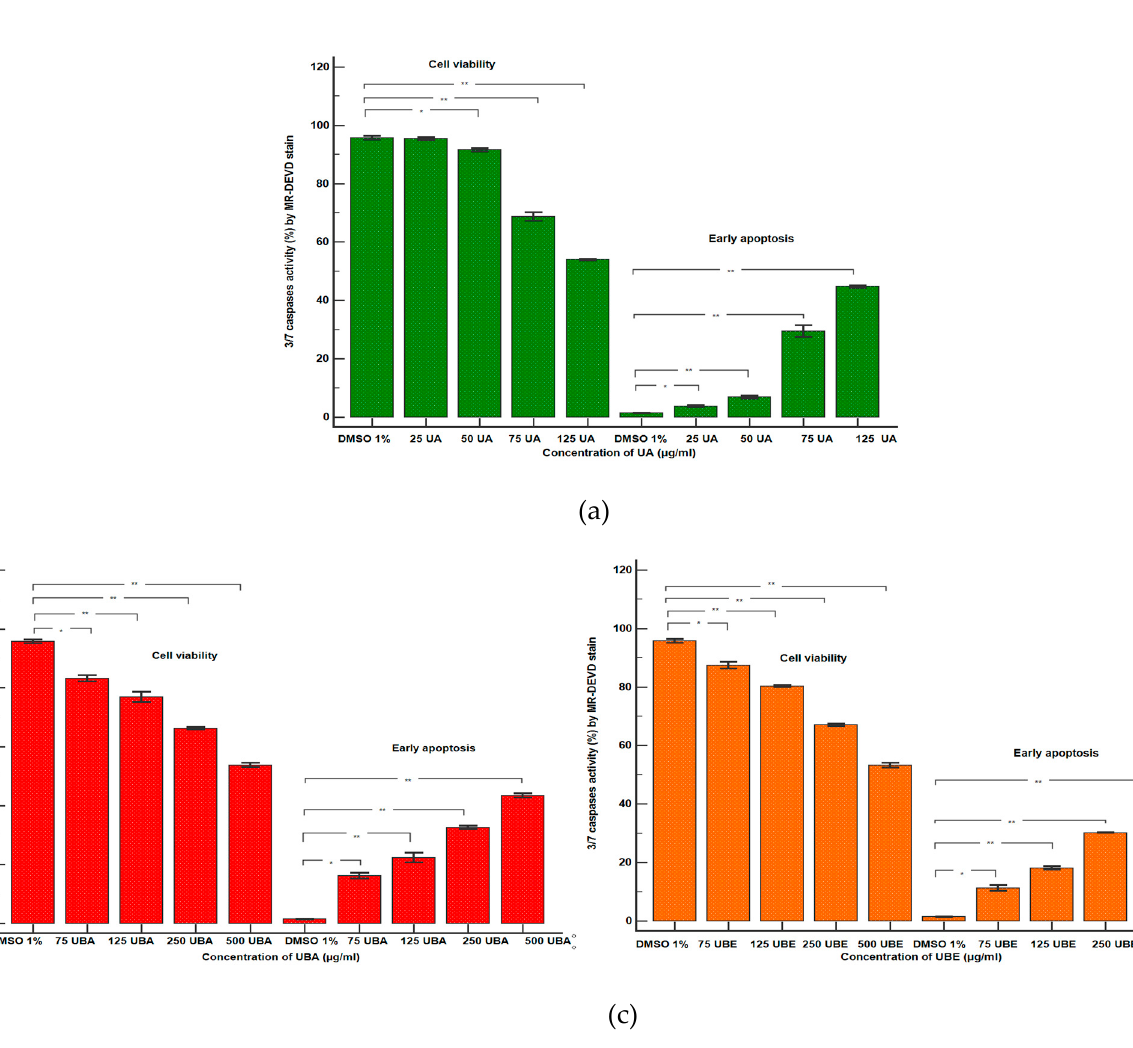
Figure 5. Statistical analysis of caspase 3/7 activity: ( a ) UA; ( b ) UBA; ( c ) UBE. * p < 0.01 and ** p < 0.001 represent significant statistical differences between the control and samples made by paired samples t -test.